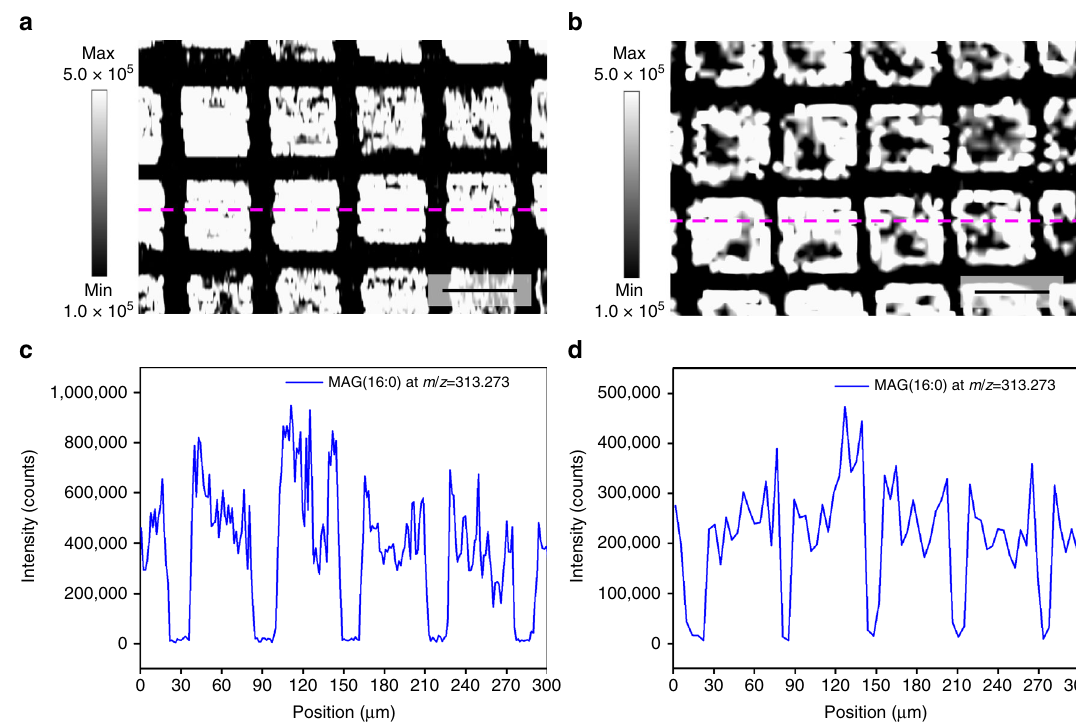
Fig. 5 The x -axial lateral resolution test of AP-nanoPALDI imaging in a hippocampal specimen on 400mesh grid. Ion images for MAG (16:0) ion at m / z = 313.273 were taken during the analysis of the hippocampal tissue slice (the area of 300 × 200 µ m) on a TEM grid with 400mesh when the sample moving velocities were set to a 10 µ m s − 1 and b 30 µ m s − 1 , respectively. Scale bars, 50 μ m. The line scans were obtained from the MAG (16:0) ion image at the average of the three neighboring scan lines (magenta dashed line). The resulting line scan ( c ) corresponds with ion image ( a ), and line scan ( d ), corresponds with ion image ( b ). As a result, the x -axial lateral resolutions achieved were 2.9 ± 0.6 and 5.1 ± 1.1 µ m when the sample moving velocities were 10 and 30 µ m s − 1 , respectively. They represented means ± SDs from 10 distinct edges in each case as shown in c and